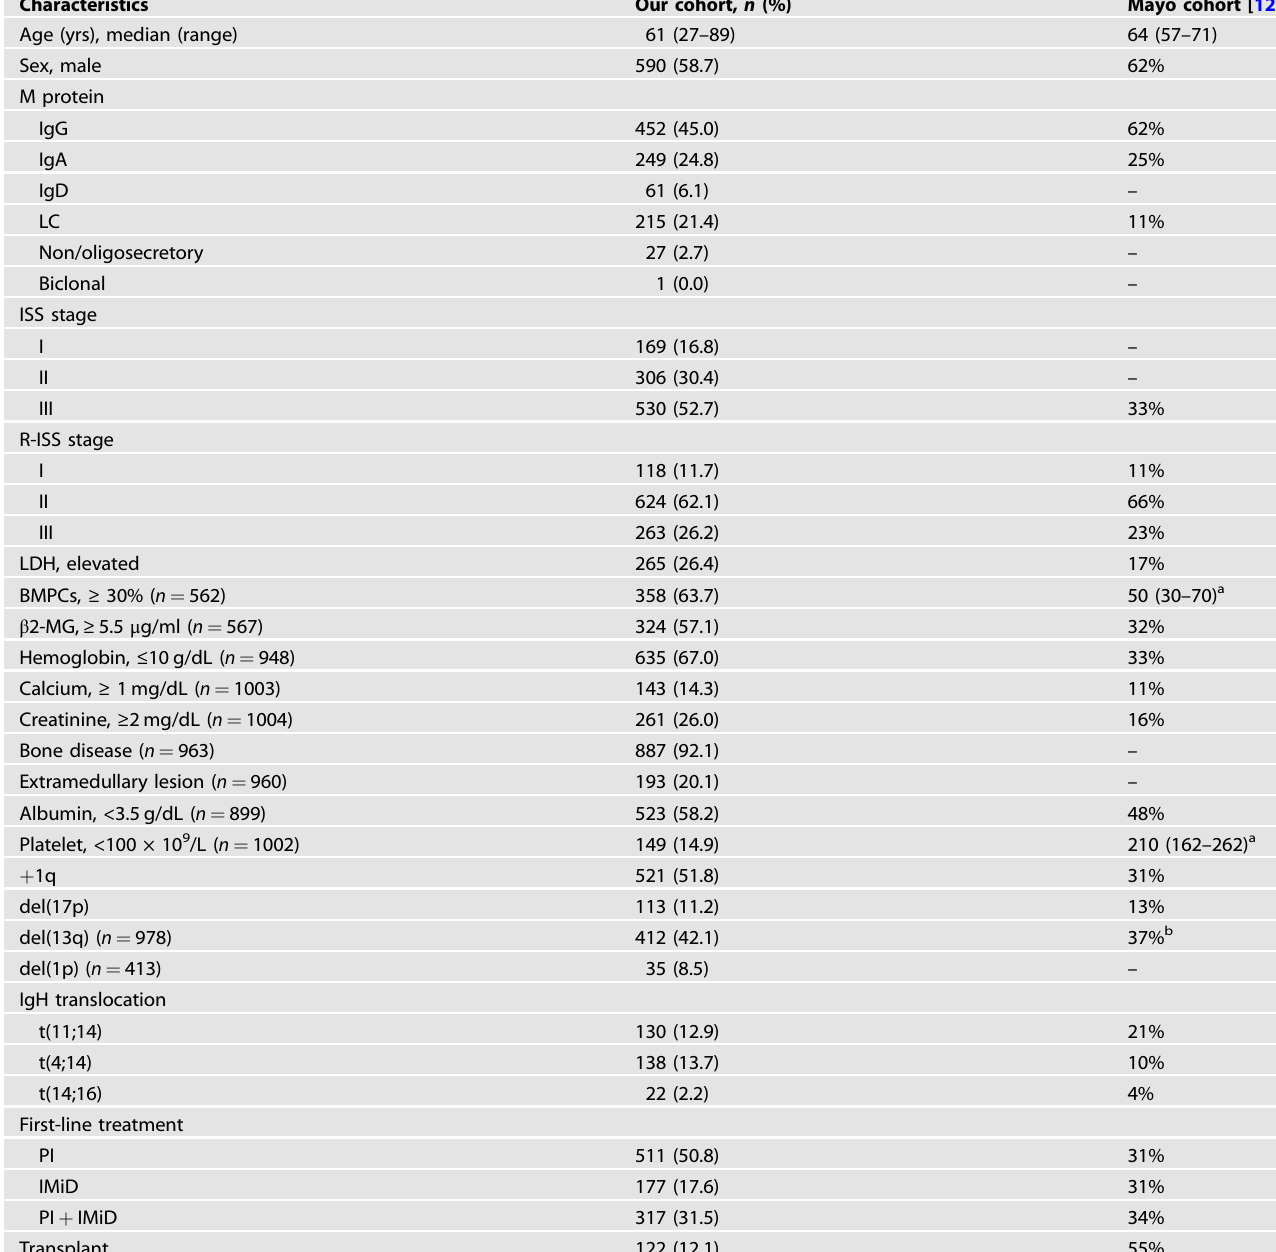
Table 1. Comparison of baseline characteristics between two